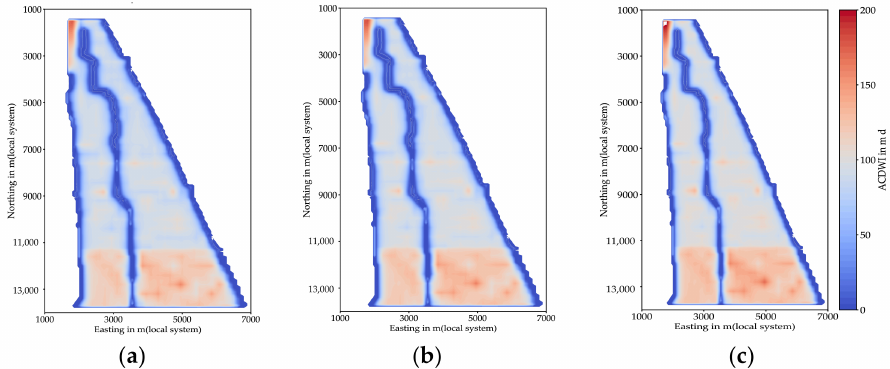
Figure 12. Spatial distribution of ACDWI in the corn growth period in different hydrological years: ( a ) 2004, ( b ) 2008 and ( c ) 2014.